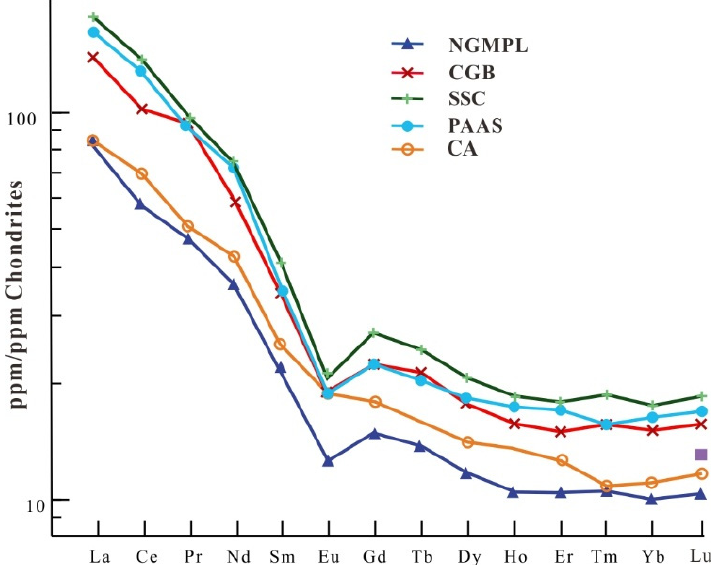
Figure 7. Chondrite-normalized REEs diagrams. (Chondrite and PAAS data after [54,55]). REEs,